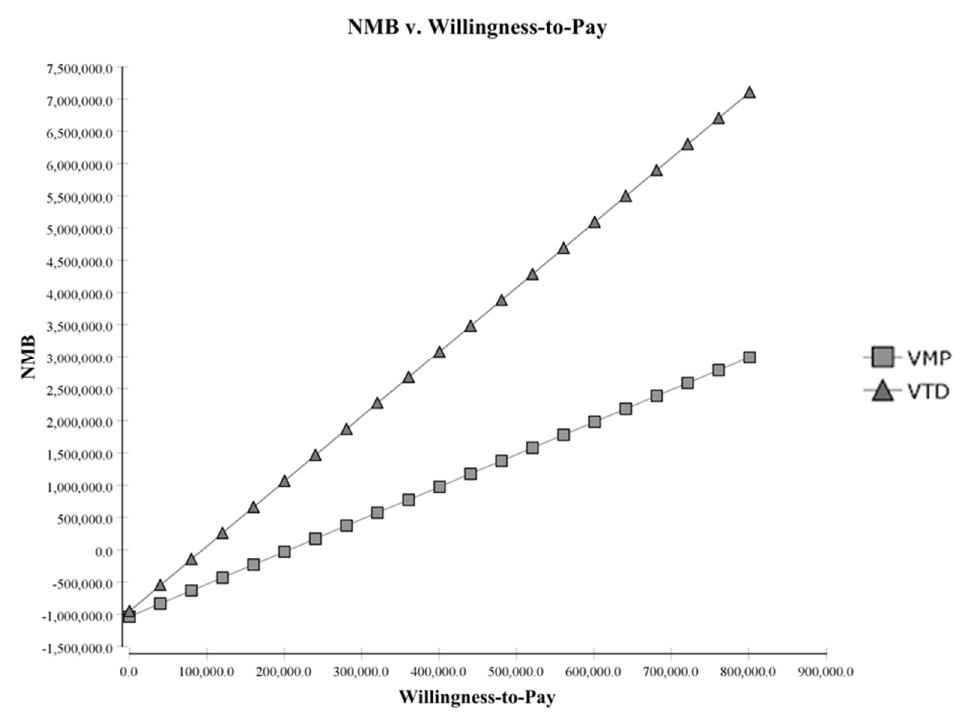
Figure 3. Net monetary benefit with different willing-to-pay prices.